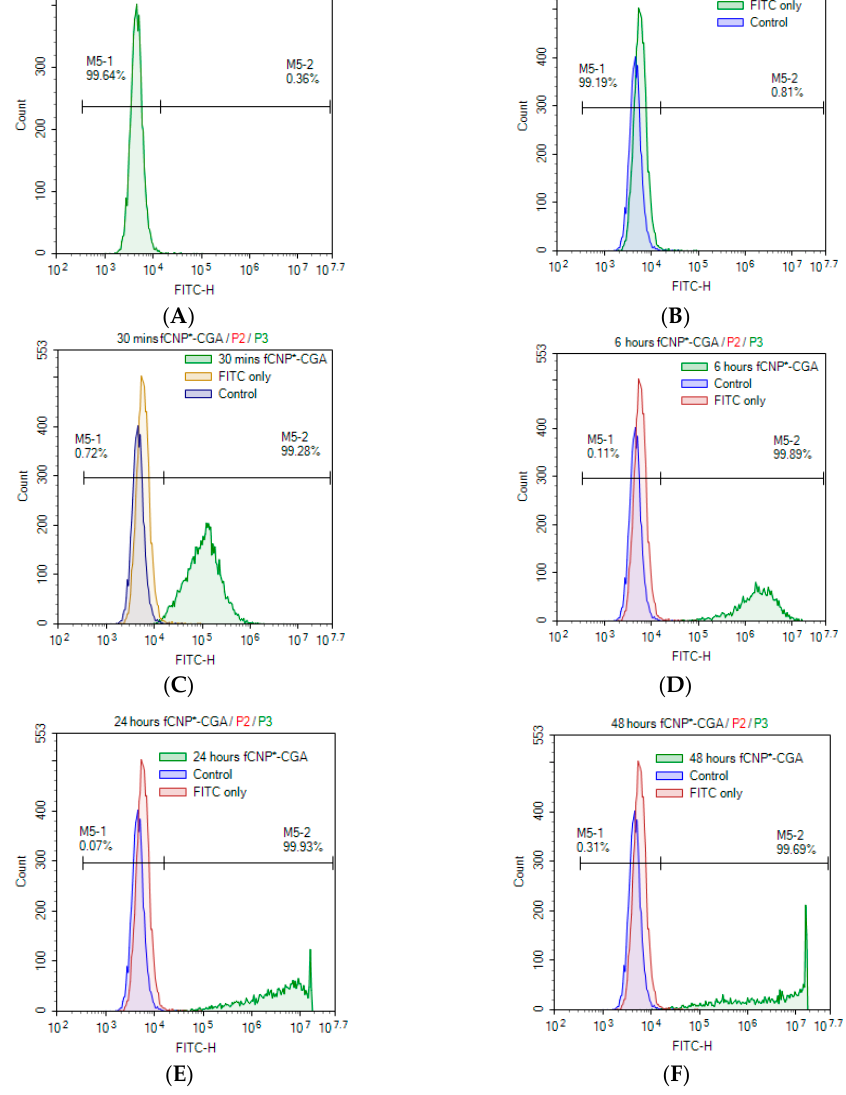
Figure 11. Flow cytometry study of in vitro accumulation of f CNP°-CGA in 786-O cells at ( C ) 30 min, ( D ) 6 h, ( E ) 24 h, and ( F ) 48 h. Overlap peaks of particular time point on ( A ) control and ( B ) FITC only